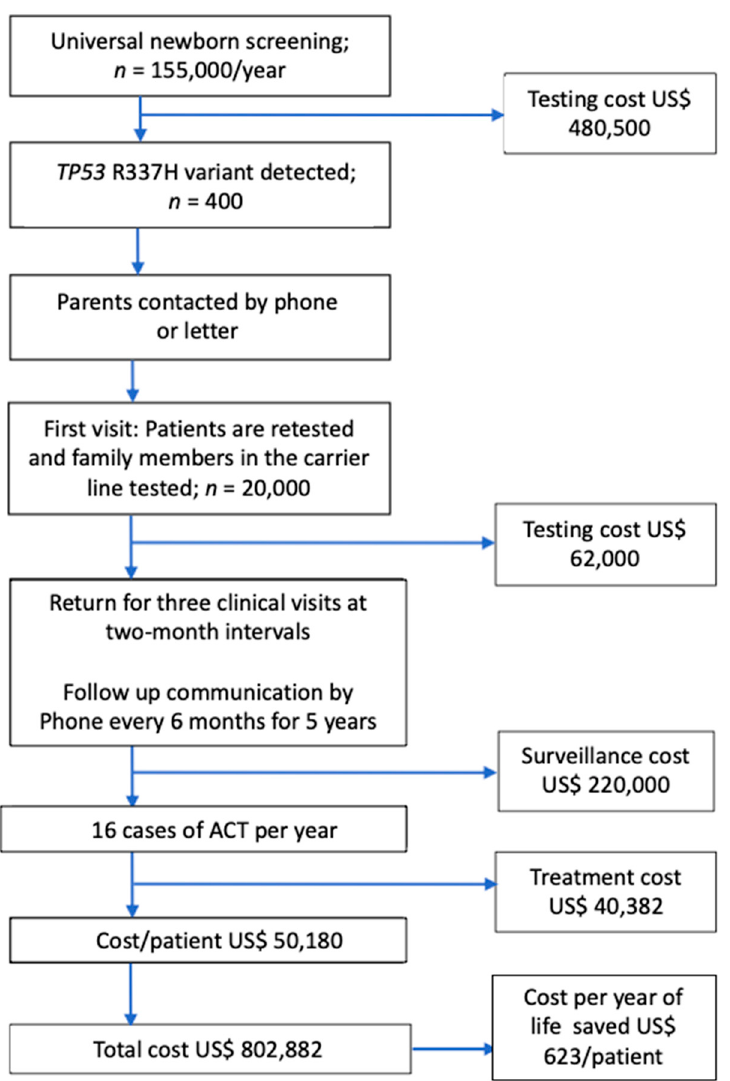
Figure 2. Cost of screening and surveillance. Considering a life expectancy of 60 years, the cost per year of life saved is US$ 623 per patient. year of life saved is US$623 per